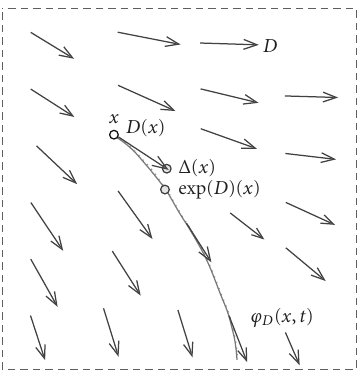
Figure 2: The di ff eomorphic flow exp( D ) associated to the vector field D is the solution at time t = 1 on the trajectory tangent to D at each point (here represented in 2D). We see that the motion of x induced by exp( D )( x ) is more compatible with V than this produced by Δ ( x ) = x + D ( x